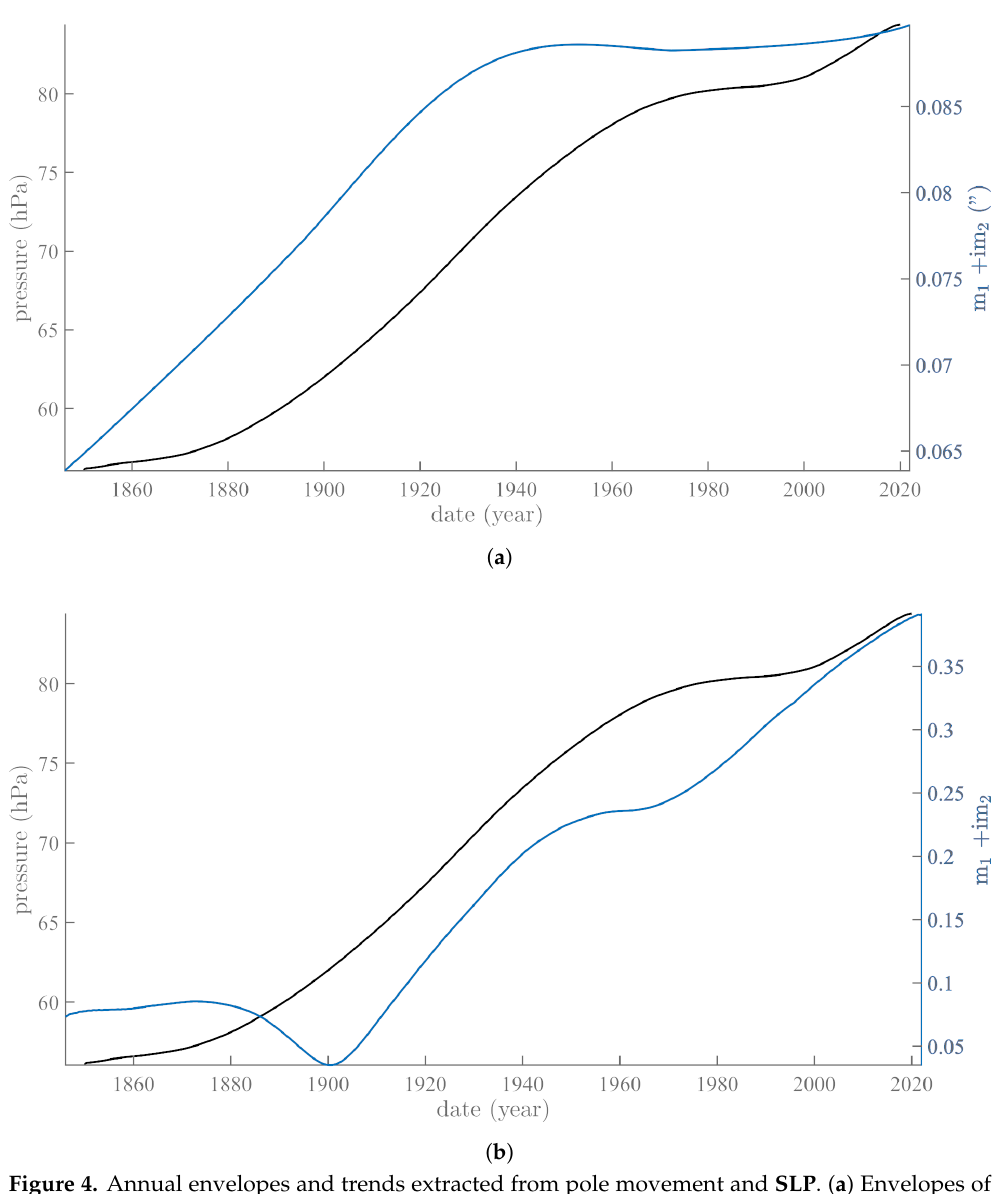
Figure 4. Annual envelopes and trends extracted from pole movement and SLP . ( a ) Envelopes of oscillations of iSSA annual components of polar motion m (blue curve, right scale) and global sea-level pressure SLP (black curve, left scale). ( b ) Trend of the pole movement (blue curve) and envelope of iSSA component of atmospheric pressure SLP (black